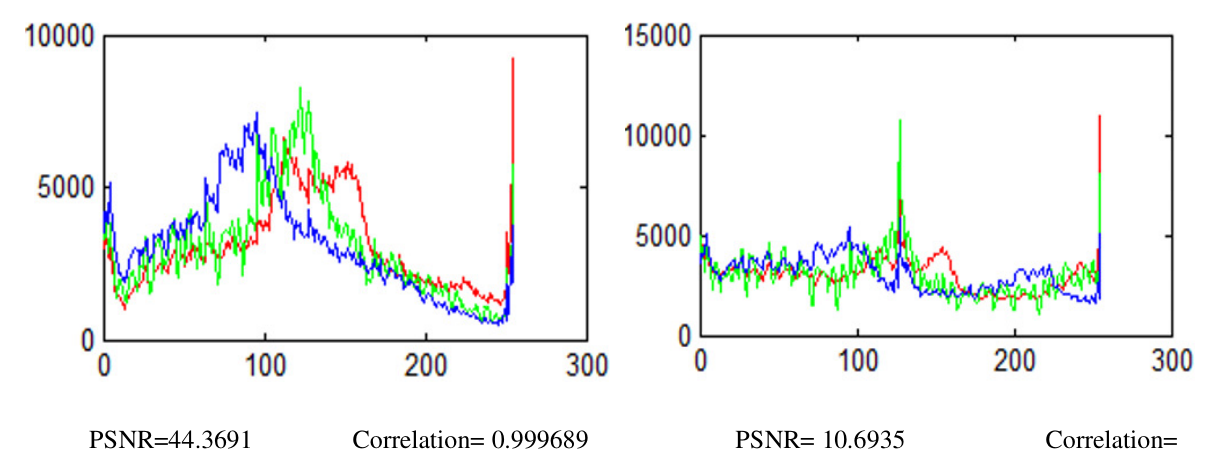
Fig. 4. Evaluation results for hidden secret text of (104